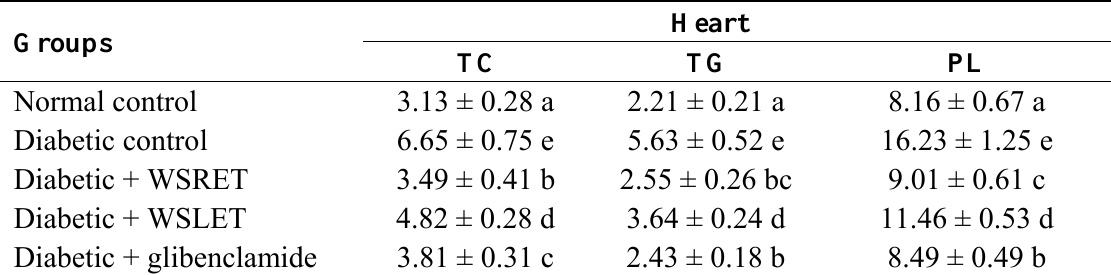
Table 6. Effects of W. somnifera (L.) extracts on heart